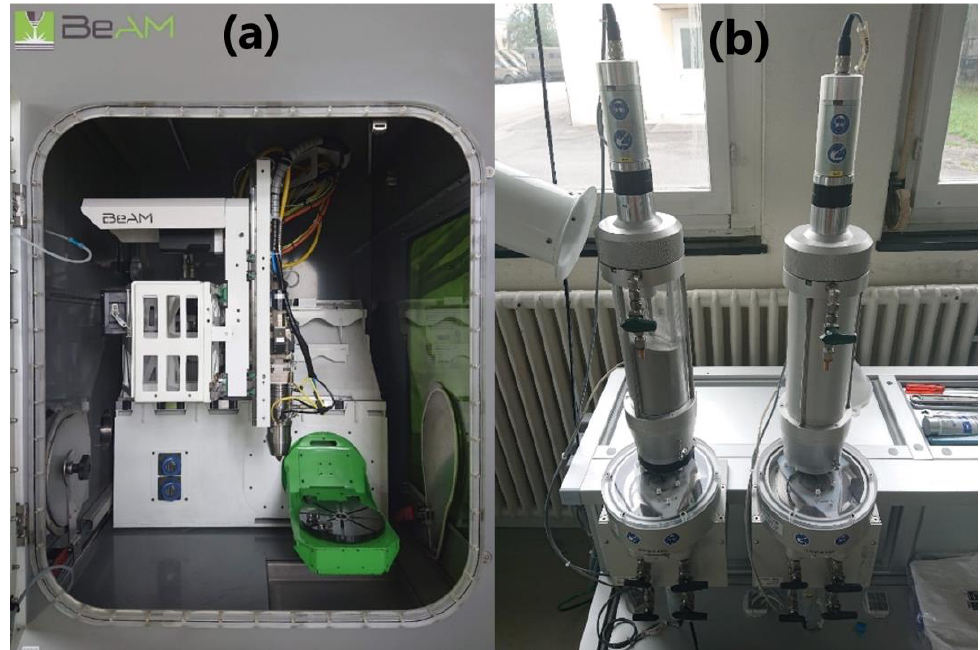
Figure 2. ( a ) The interior of the process chamber of the laser metal deposition (LMD) machine. ( b ) The powder feeder with two powder containers.